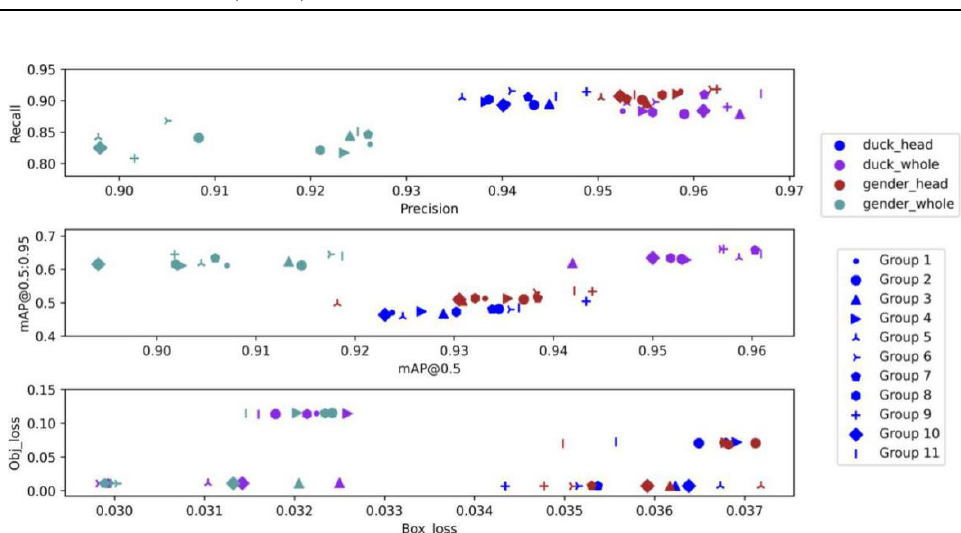
Figure 12. Ablation experiment corresponding to the four schemes, with each point corresponding to a group of tricks, in which each color represents each scheme and the shape of each point represents different experimental groups. The comparison shows that when focal loss calculation is introduced and HSV_Aug, Mosaic, MixUp, Fliplrud, and RandomScale are used, there is a degree of improvement in mAP, although the Yolov5 model does not have a significant advantage in terms of precision and recall compared to the other combinations. The results show that group 11 is the